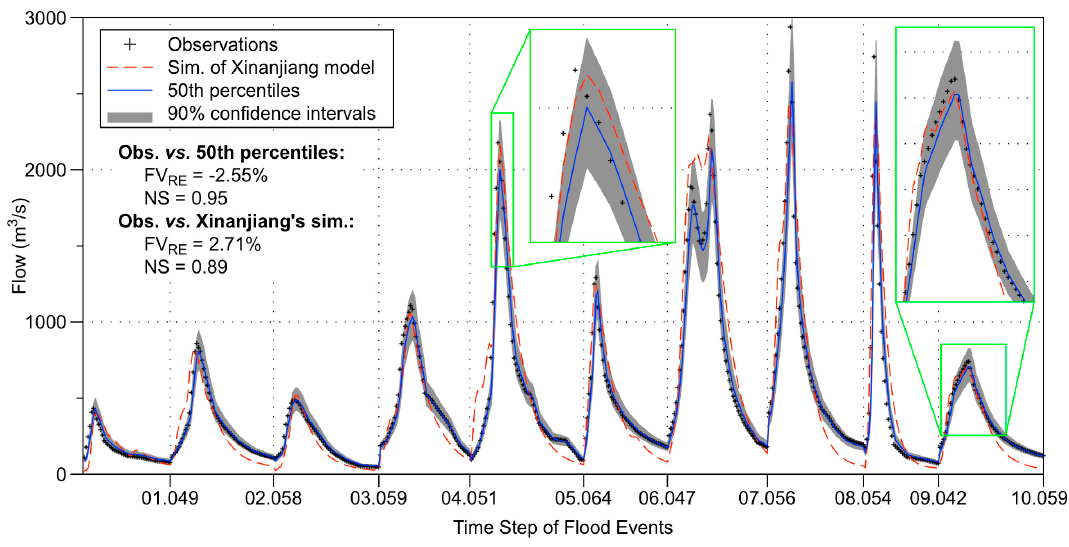
Figure 5. Hydrologic Uncertainty Processor (HUP) forecasts compared to the observations and the simulations of Xinanjiang model. Green boxes magnify the zone of peak time steps. The same flood events are used as shown in Figure 4c. The numbers on the bottom axes —with the two ‐ digit format of for flood ID and three ‐ digit for ending time step—separate the artificially attached series of flood events.